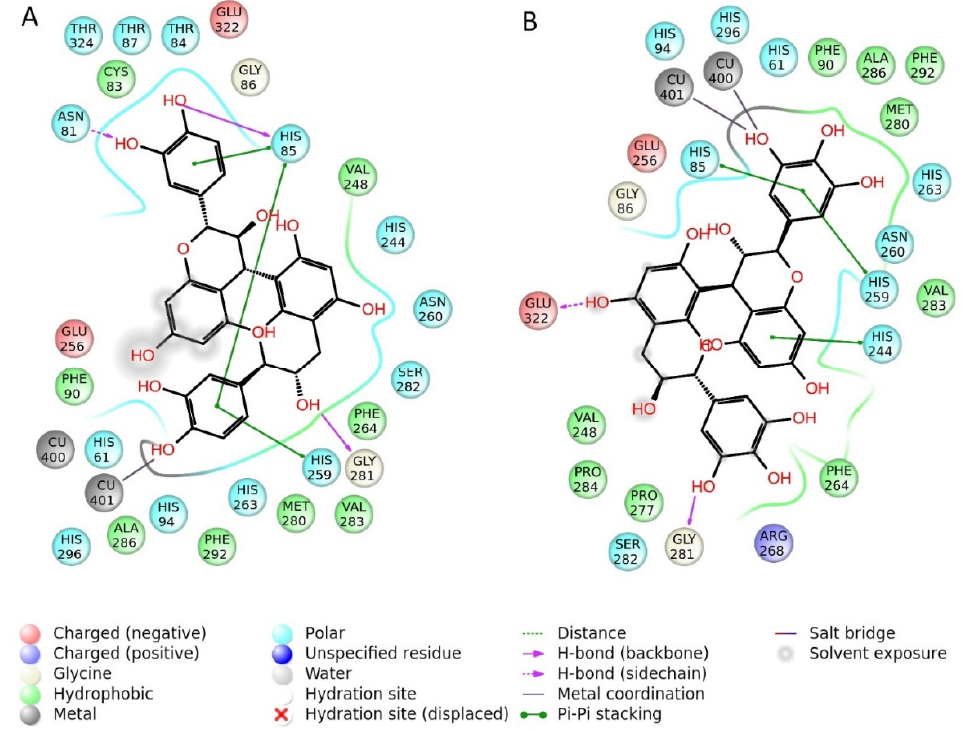
Figure 1. ( A ) Procyanidin B3; ( B ) Prodelphynidin B3 docked to